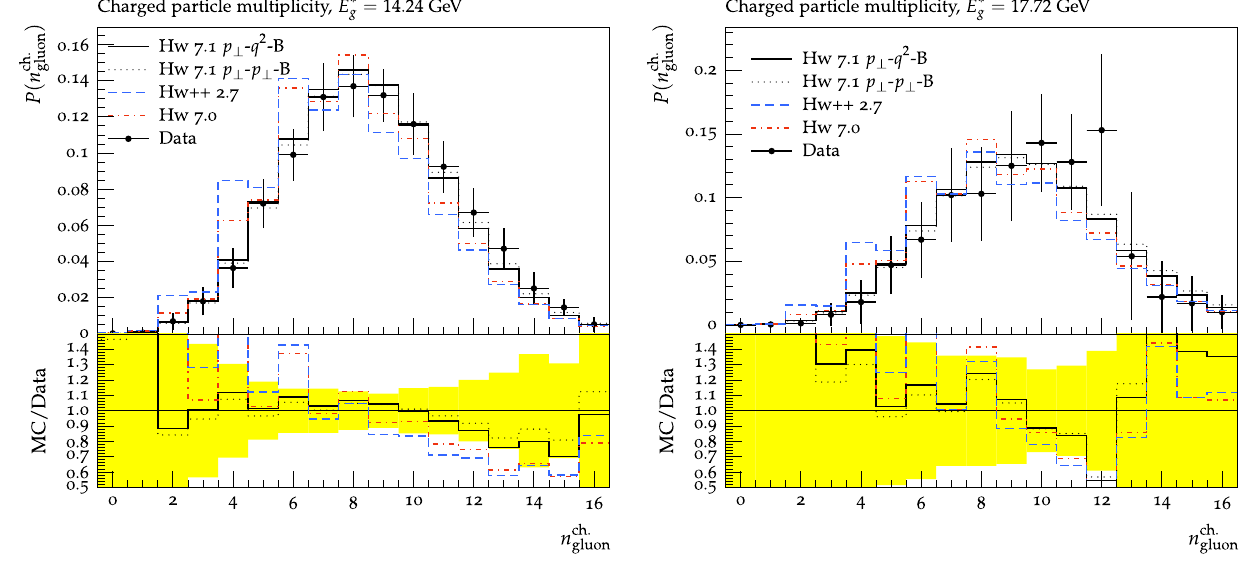
Fig. 7 Multiplicity distribution of charged particles in gluons jets for two different gluon energies compared with data from OPAL